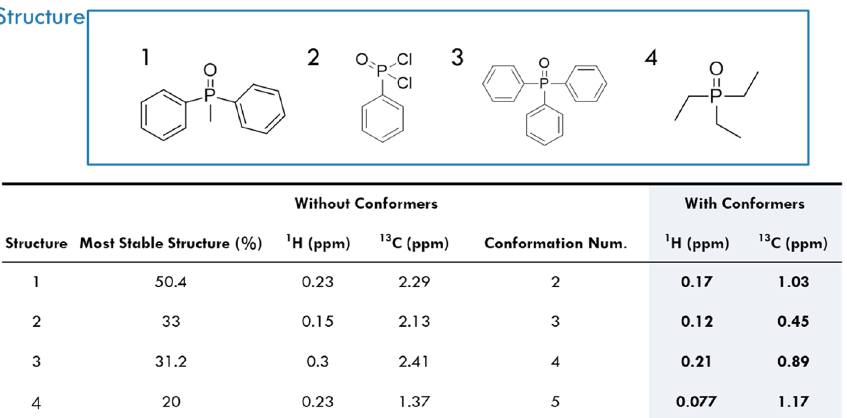
Figure 1. Experimental and calculated OP structures and the average MAE between experimental and calculated data, both with and without conformer considerations. Chloroform was used for experimental sampling; therefore, the M06-2X/6-311 + G(2d,p) and MPW1PW91/6-311 + G(2d,p) functionals/basis set combinations were used for the DFT study.